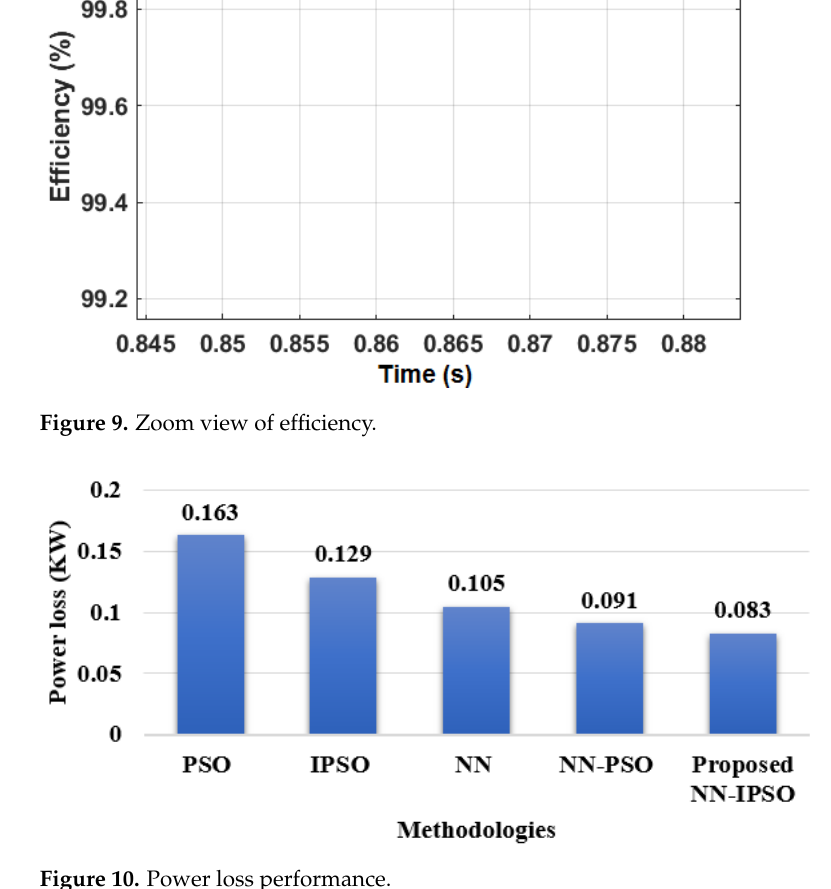
Figure 10. Power loss performance.